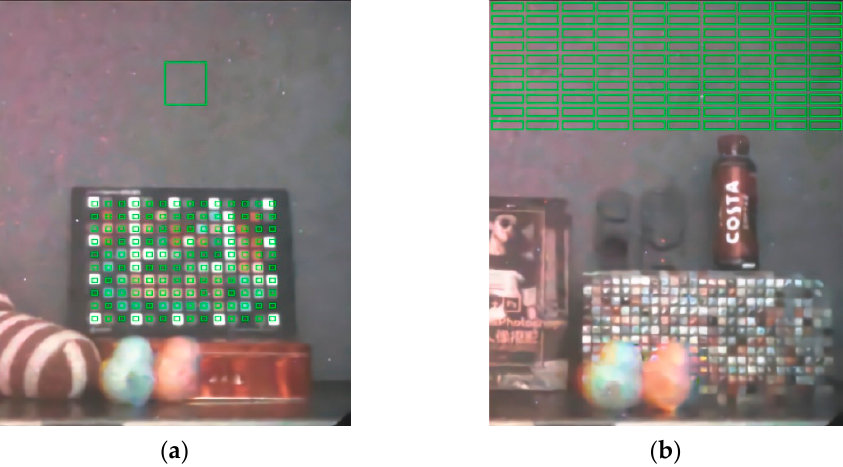
Figure 12. The selected flat areas for NRIQA calculation: ( a ) scene 1; ( b ) scene